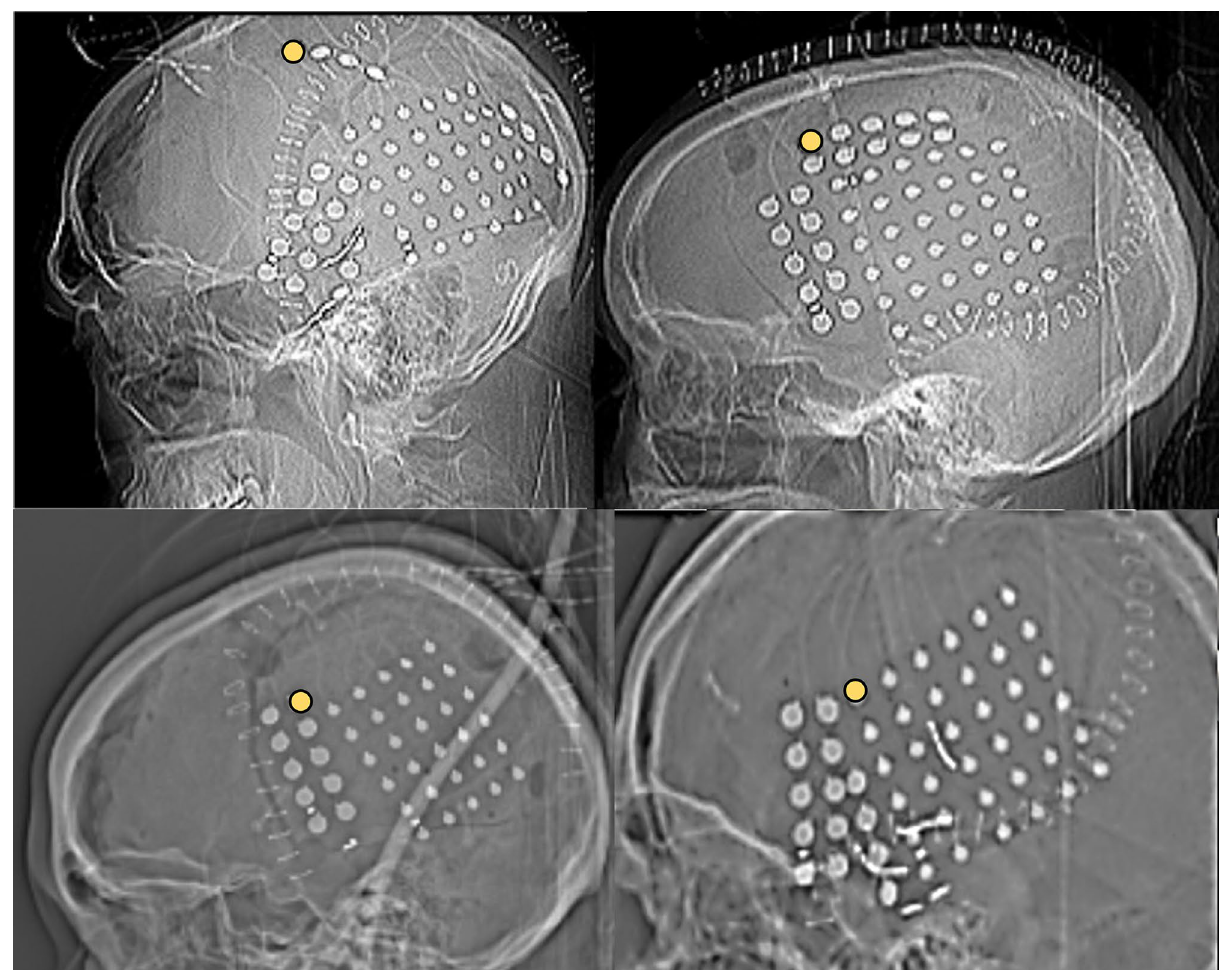
Figure 3. Human electrode position Lateral radiographic images of human electrocorticography grid and strip position. The circular recording electrodes are discernible from the curvilinear surgical staples. Highlighted electrodes (yellow) were selected for power compassions with the